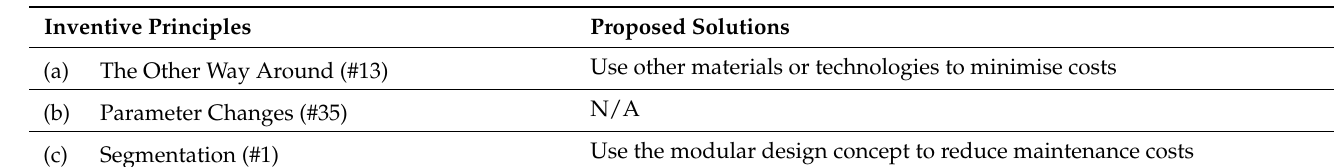
Table 13. Proposed solutions based on principles from of parameters #27 and #36 within the contradiction matrix.